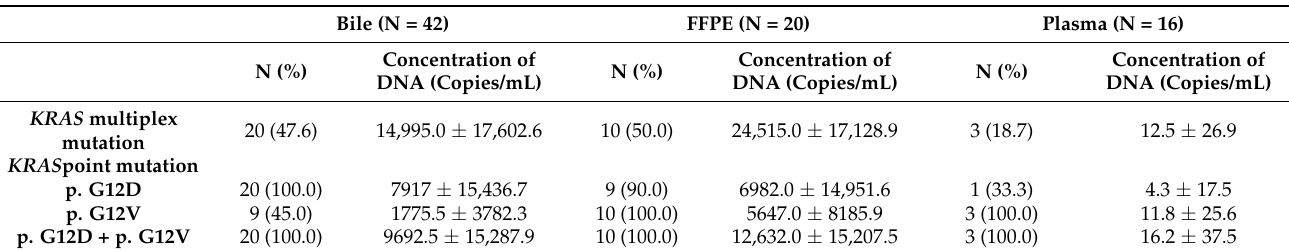
Table 2. Incidence of KRAS mutations and concentrations of DNA in bile ctDNA, FFPE DNA, and plasma DNA from BTC patients. The 2D plotted data (black dots: FAM − /HEX + ; blue dots: FAM − /HEX + ; brown dots: FAM − /HEX + ; green dots: FAM − /HEX + ) from the ddPCR multiplex KRAS assay. Both the 12D and 12V point mutations were detected in the bile ctDNA, plasma DNA, and FFPE DNA samples. Presence of mutation was defined by copy number variation as cut-off value (bile > 1500 copies/mL, plasma > 60 copies/mL, and FFPE > 4500 copies/mL). All panels show FAM amplitudes of up to 12,000 and HEX amplitudes of up to 12,000.